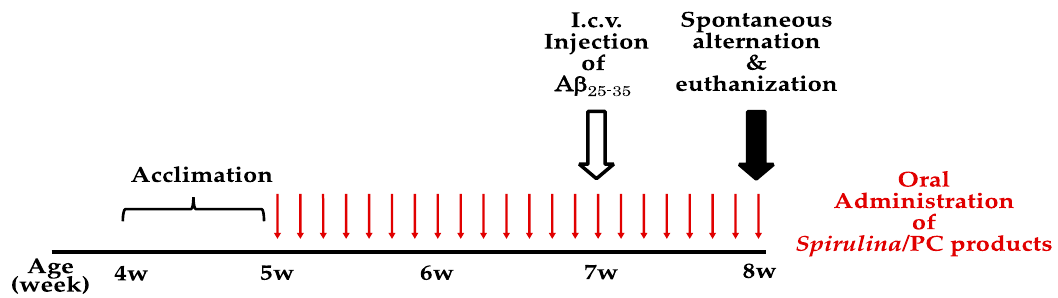
Figure 1. Experimental scheme. After one week of acclimation, the mice were treated with Spirulina (750 mg/kg), ED Spirulina (750 mg/kg), PC (750 mg/kg and 120 mg/kg), EDPC (750 mg/kg), or vehicle (distilled water) by daily oral administration for 22 consecutive days. At 7 weeks of age, the mice were intracerebroventricularly (i.c.v.) injected with A β 25–35 (A β , at 10 nmol/head or vehicle. On the day of i.c.v. injection, the mice received the test substances or vehicle by oral administration more than 30 min prior to the injection. On the day of the spontaneous alternation test and euthanization, the mice were treated with the test substances or vehicle 60 min prior to the test.